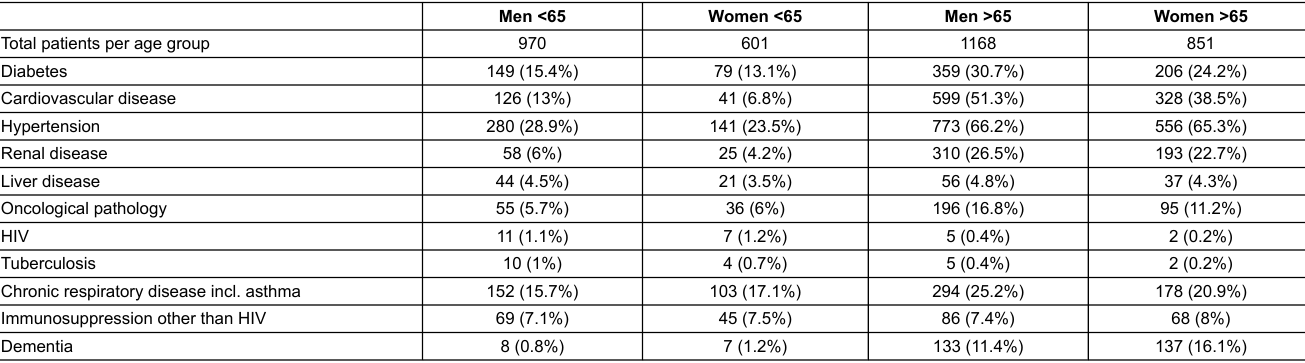
Table 2: Frequency of comorbidities by age category and gender for 3590 adult patients hospitalised for COVID-19 in